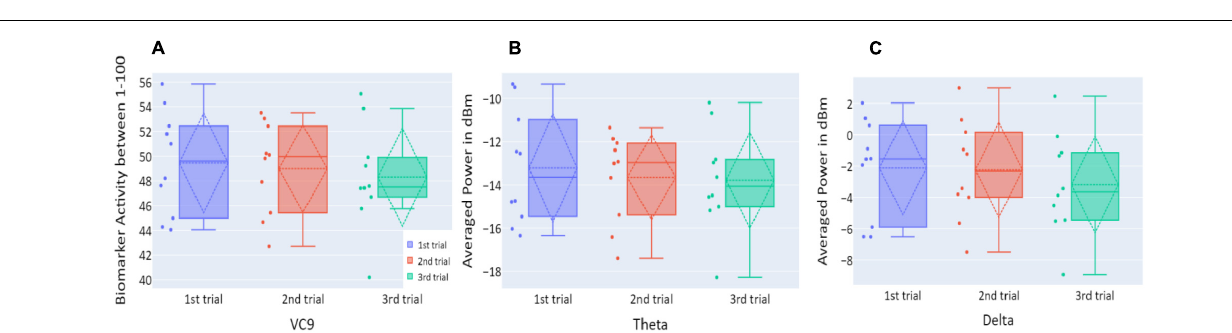
FIGURE 6 | (A) The distribution of user VC9 activity (normalized between 1 and 100); (B) the distribution of theta (averaged power of 4–7 Hz in dBm); and (C) the distribution of delta (averaged power of 0.5–4 Hz in dBm), obtained in the three trials of Experiment 2, as a function of task repetitions: first trial (blue), second trial (red), and third trial (green), for all participants ( n = 10). Dashed lines represent means and SDs. ∗ p < 0.05, ∗∗ p < 0.01, and ∗∗∗ p <